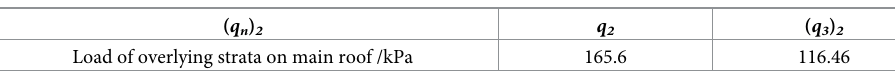
Table 3. A load of overburden strata on the main roof of No.7 coal seam.